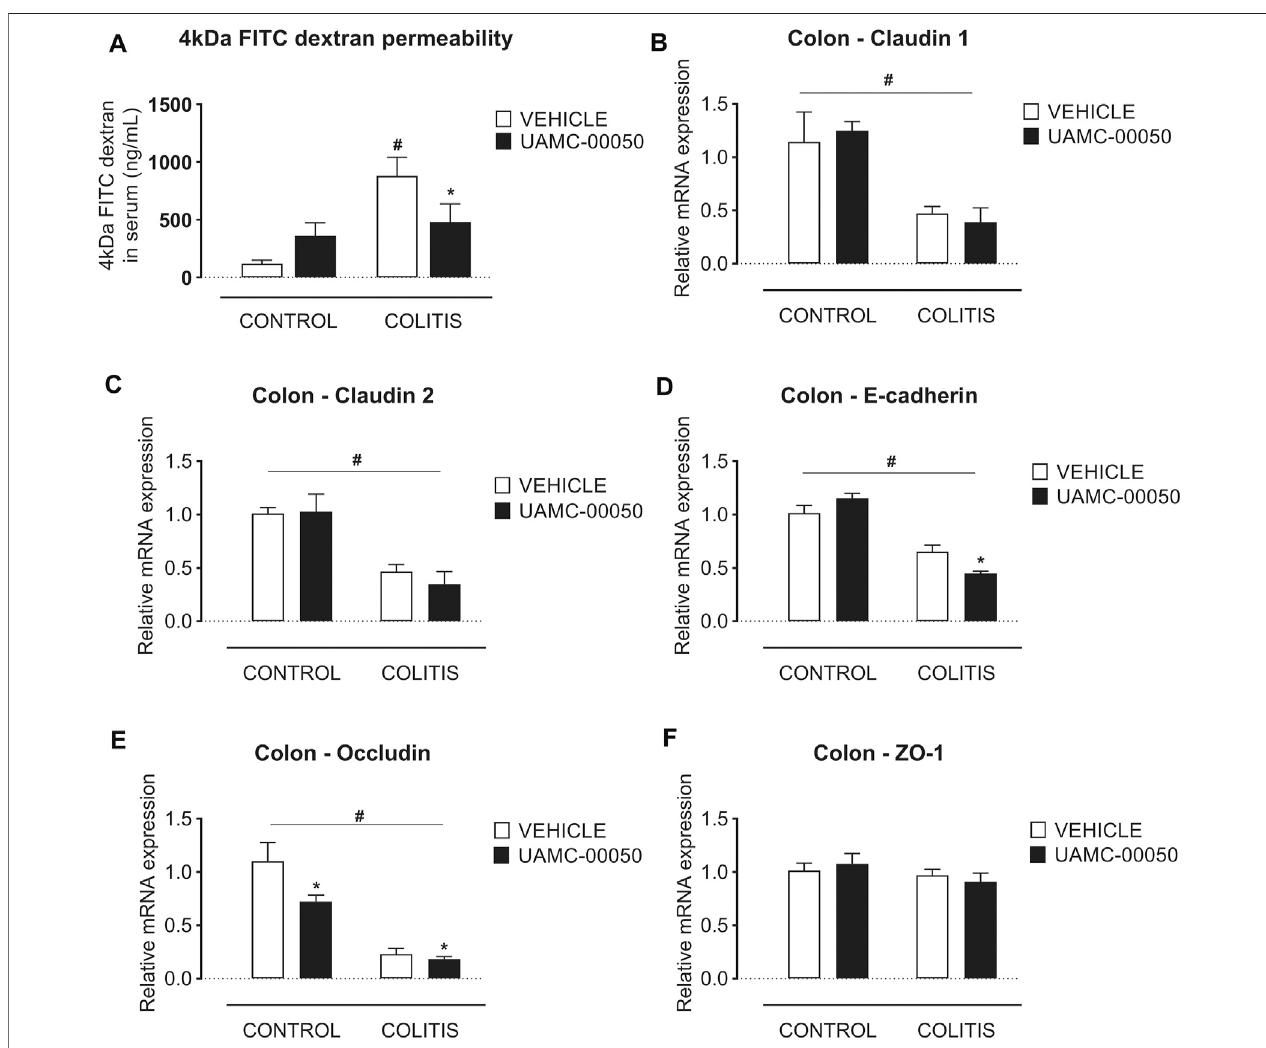
FIGURE 7 | Effect of curative treatment with UAMC-00050 on intestinal permeability in experimental colitis. Effect on 4 kDa FITC-dextran intestinal permeability, signi fi cantinteractionbetweenfactor “ colitis ” and “ treatment ” (A) andrelativemRNAexpressioninthecolonofthetightjunctionsclaudin-1 (B) ,claudin-2 (C) ,E-cadherin (D) , occludin (E) and ZO-1 (F) . Data are determined post-mortem at week 4 (after a 2-week treatment with UAMC-00050). Data are represented as mean ± SEM. Two- wayANOVA followedbyOne-wayANOVAandLSDpost-hoctest whenappropriate. # p < 0.05;signi fi canteffectofcolitis,* p < 0.05;signi fi canteffect oftreatment, n (cid:2) 7 –